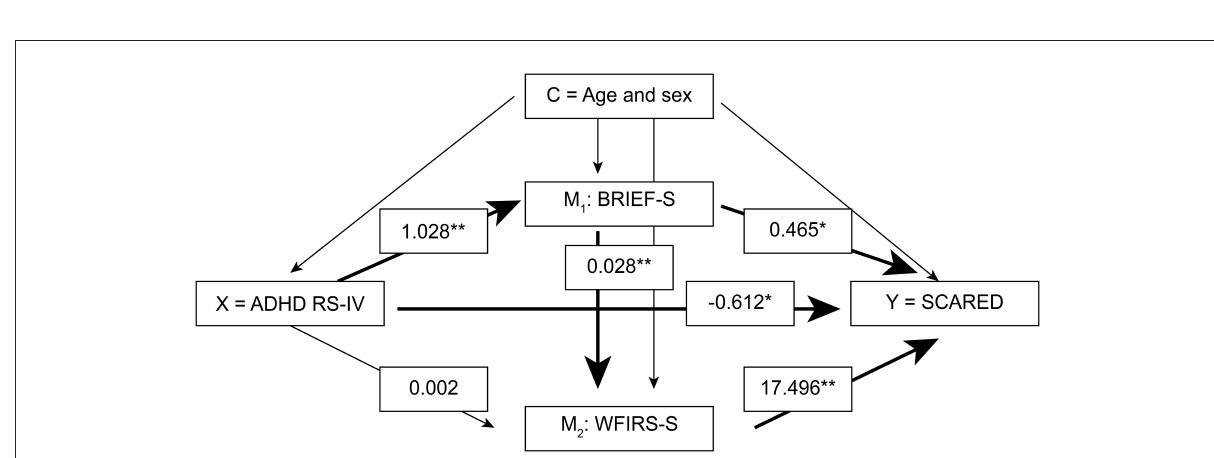
FIGURE3 Regression coefficients for the associations between self-report measures of ADHD RS-IV and SCARED with BRIEF and WFIRS as possible mediators. Age and sex were considered confounders ( n = 81). X predictor, Y dependent variable, C confounder, M 1 mediator 1, M 2 mediator